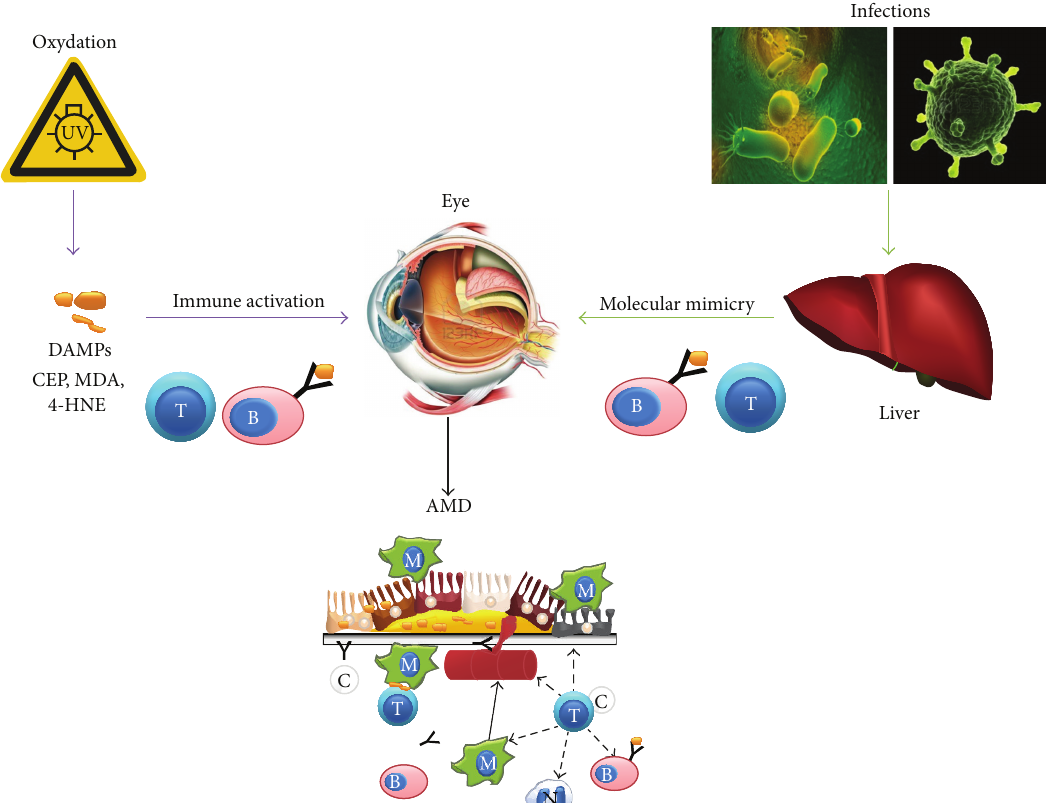
Figure3:PotentialsourcesofautoimmunityinAMD.ActivationofautoreactiveBandTlymphocytescouldresultfromtwodistinctpathways (see text). On the one hand, oxidative stress could induce the release of danger associated molecular patterns (DAMPs, such as CEP, MDA, or 4-HNE). These DAMPs will activate specific lymphocytes. Since DAMPs are found in large amount in ocular tissues, an immune response against RPE and retinal tissues could develop. On the other hand, total pathogen burden, that is, lifetime infections (of the liver, e.g.) by bacteria and viruses, would induce activation of infectious agents specific T and B lymphocytes. Because of the putative similarities between pathogen’s and eye’s antigens these activated T and B lymphocytes could recognize self-antigens of the eye leading to alterations of the RPE and retinal tissues observed during AMD. Symbols representing T and B lymphocytes, monocytes/M Φ , neutrophils, antibodies, and antigens are identical to those used in Figures 1 and 2. RPE: retinal pigmented